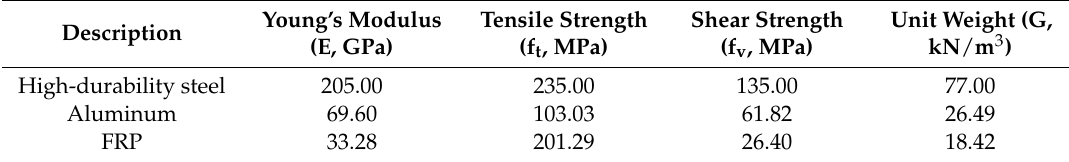
Table 1. Mechanical properties of materials.